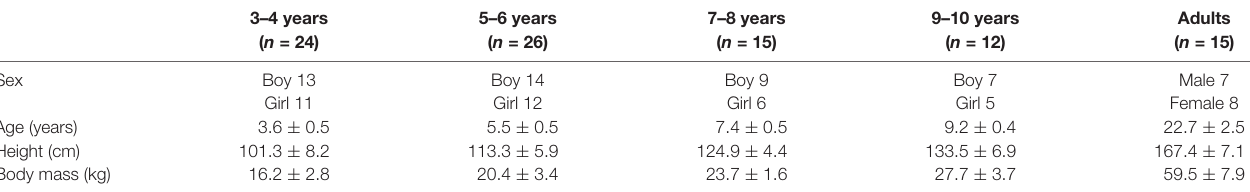
TABLE 1 | Demographic